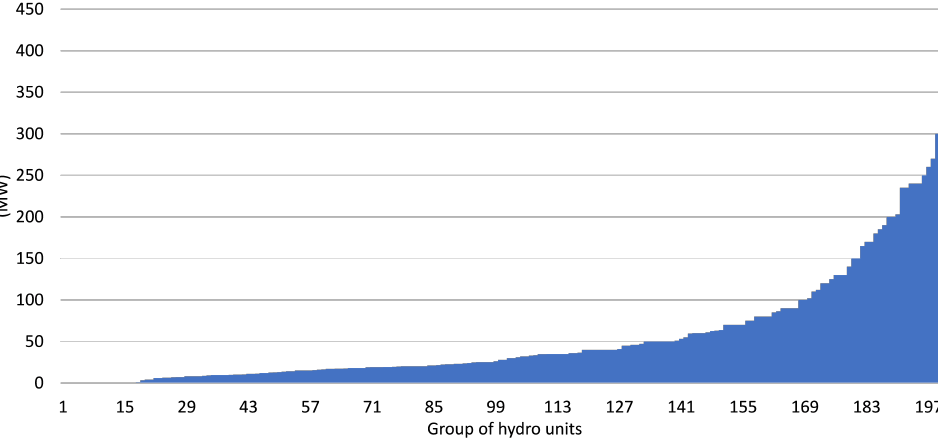
Figure 3. First forbidden zones of the groups of hydro units considered in this work. This zone is determined by the minimum generation of the group’s unit with the smallest minimum